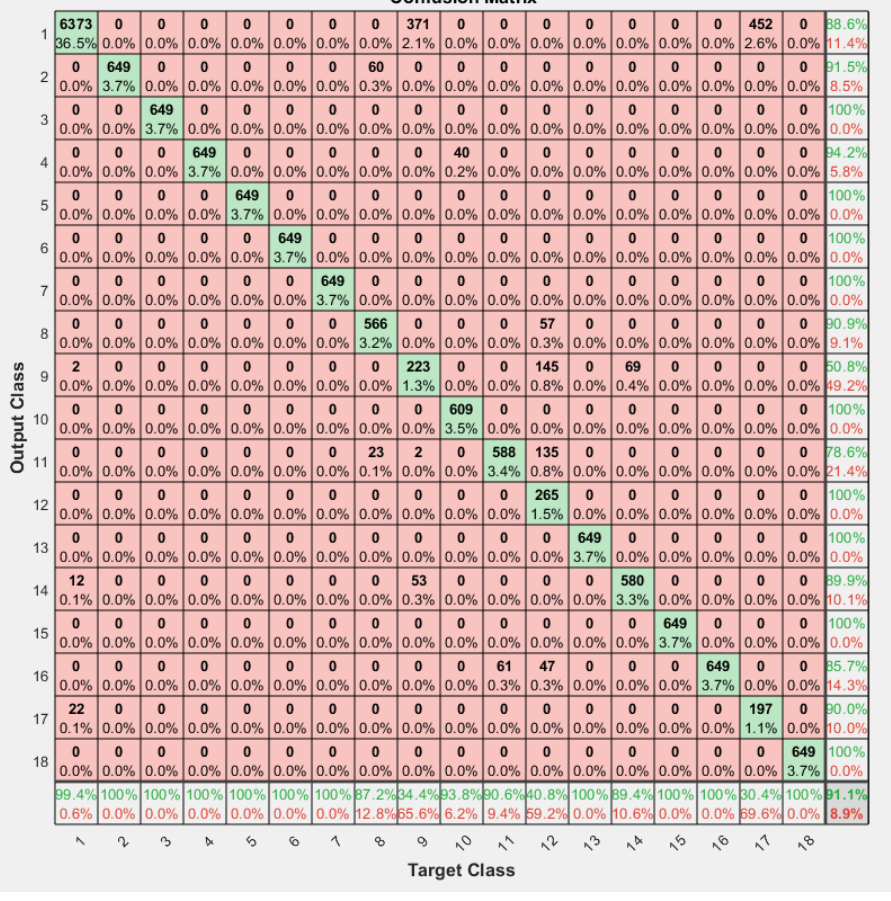
Figure 6. Confusion matrix for the first level model of the hierarchical structure (i.e., classification of non-incipient faults and considering incipient faults as a normal